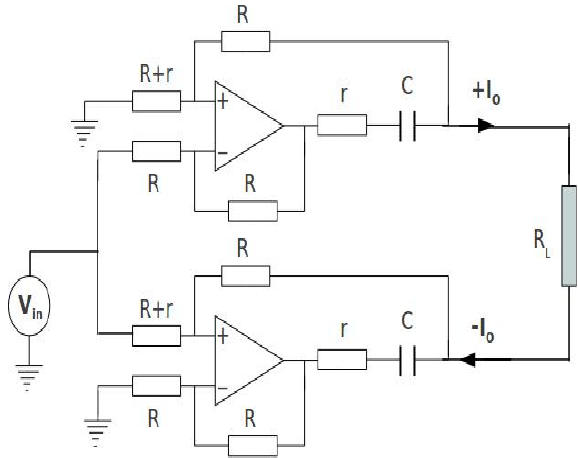
Fig.1: Schematic diagram of the simulated mirrored modified Howland current source, where R= 47 k Ω , C= 2 μ F and V in is the input